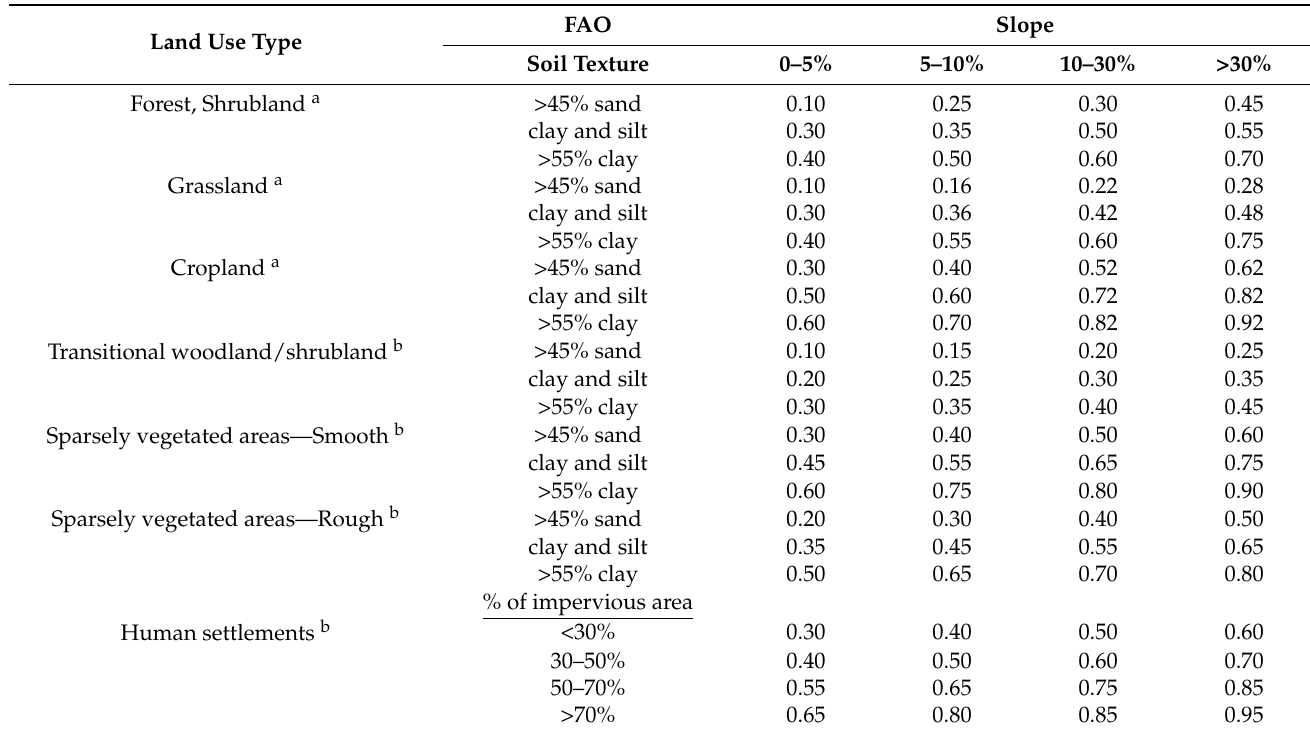
Table 2. Values of runoff coefficient (C i ) based on land use type, soil texture and slope of landscape units in the Rocha River